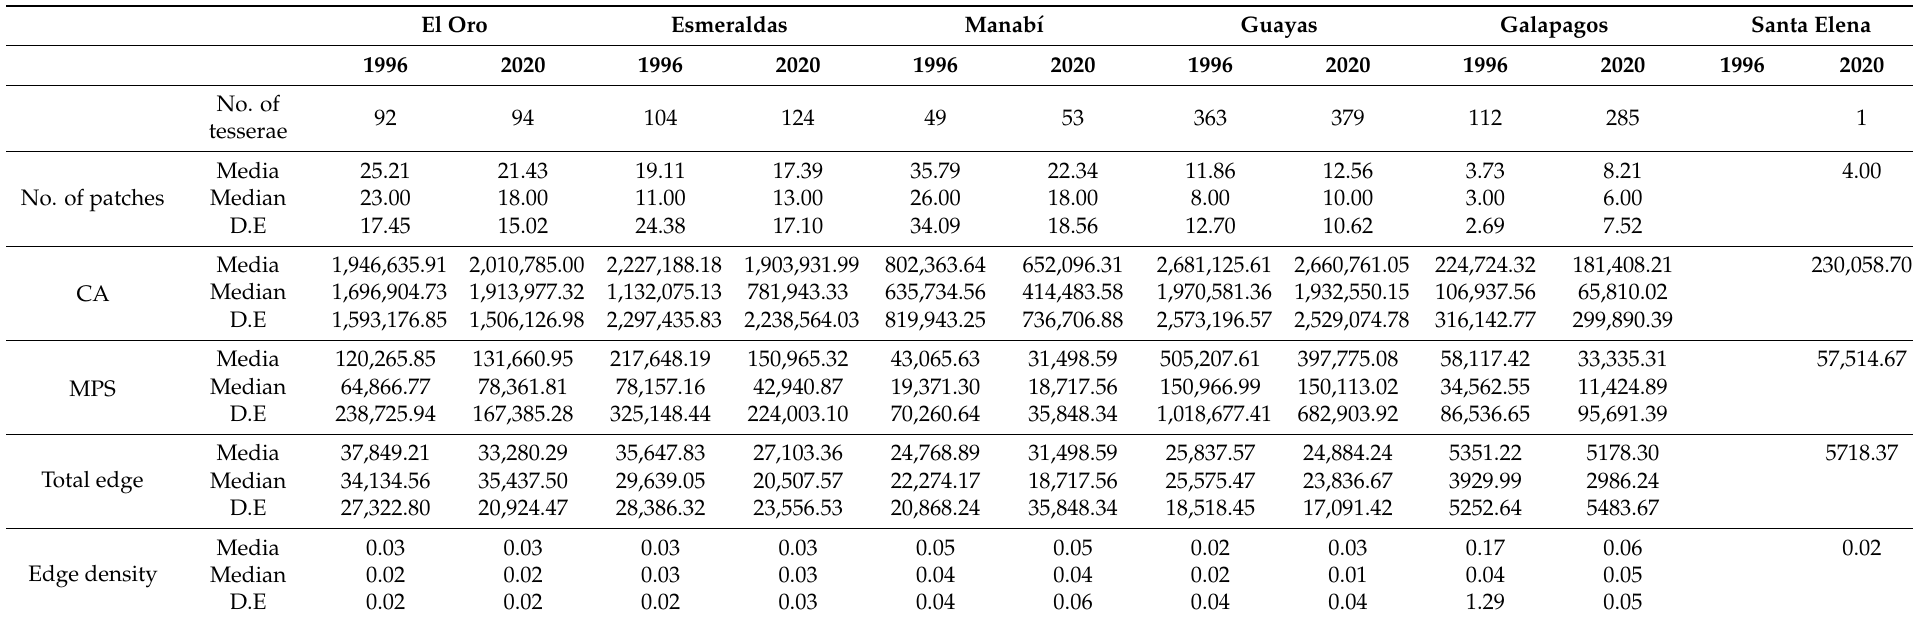
Table 4. Variation between 1990 and 2018 as regards the values obtained for the different fragmentation indicators, by province. El